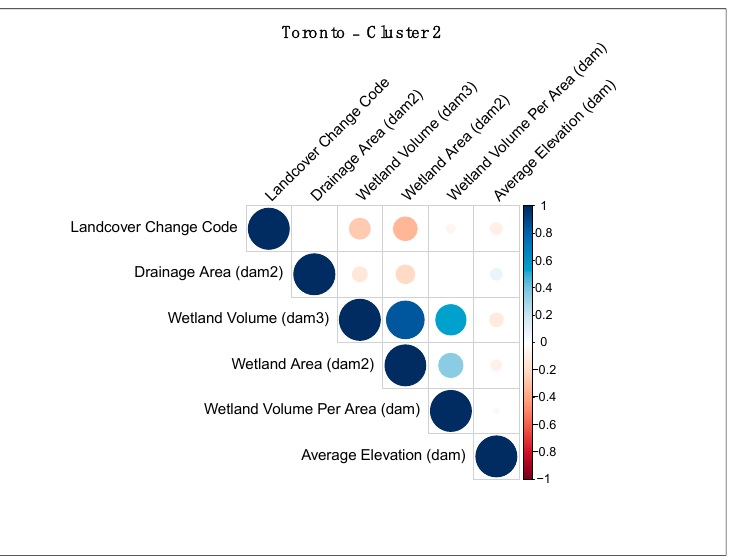
Figure 3. Toronto cluster 2 correlation matrix.